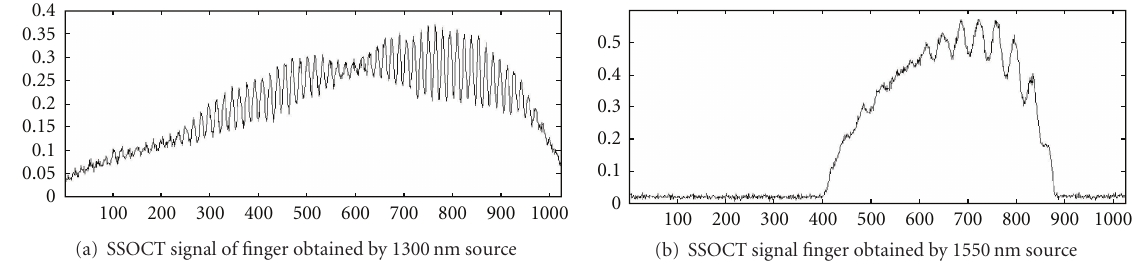
Figure 6: Raw SSOCT signals of finger. (a) SSOCT signal of finger obtained by 1300 nm source; (b) SSOCT signal finger obtained by 1550 nm